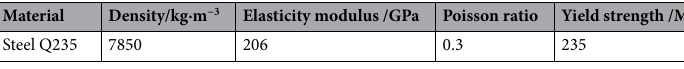
Table 2. Parameters of materials.